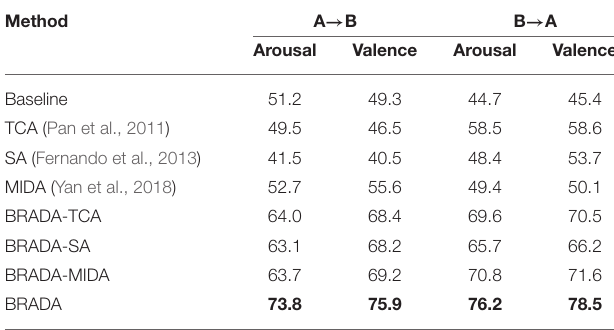
TABLE 3 | Cross-database classification accuracy (%) on MAHNOB-HCI and